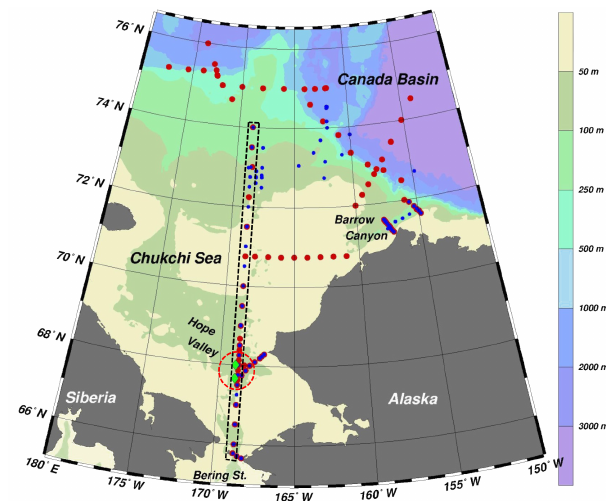
Figure 1. Map showing the bathymetric features of the study area and the hydrographic stations for the R/V Mirai cruises in 2012 (red dots) and 2013 (blue dots). Green diamonds represent the SCH-12 (southern site) and SCH-12-2/SCH-13 (northern site) mooring sites listed in Table 1. Data from the stations enclosed by black dotted lines were used for the illustrations of vertical sections shown in Figs. 5–7. The area enclosed by the red dotted circle is the southern Chukchi Sea biological hotspot, where the moorings were installed and detailed hydrographic surveys were